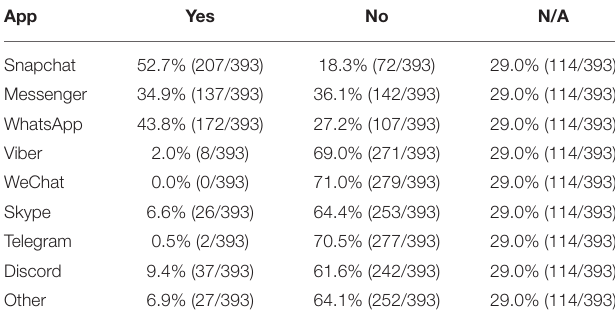
TABLE 4 | Use of messaging applications.